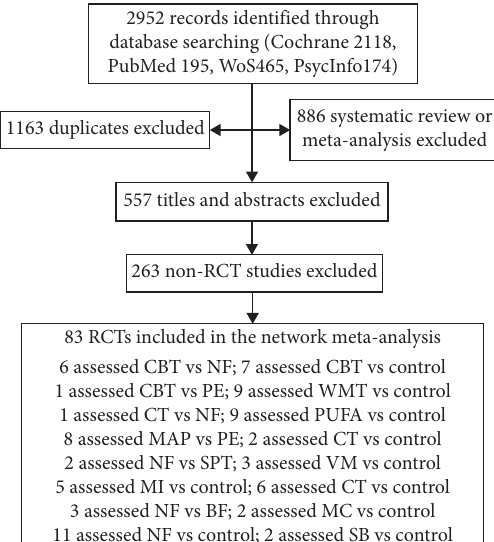
Figure 1: Flowchart of study selection.